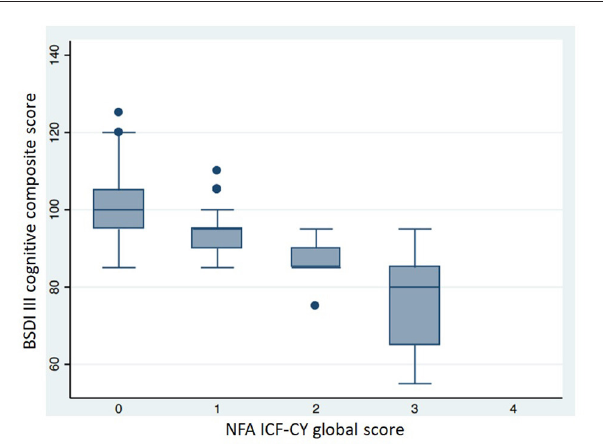
FIGURE 6 | Comparison of BSDI III cognitive composite score in patients with different NFA ICF-CY score . Patients with tetraparesis and blindness were excluded. Kruskal-Wallis test: p <